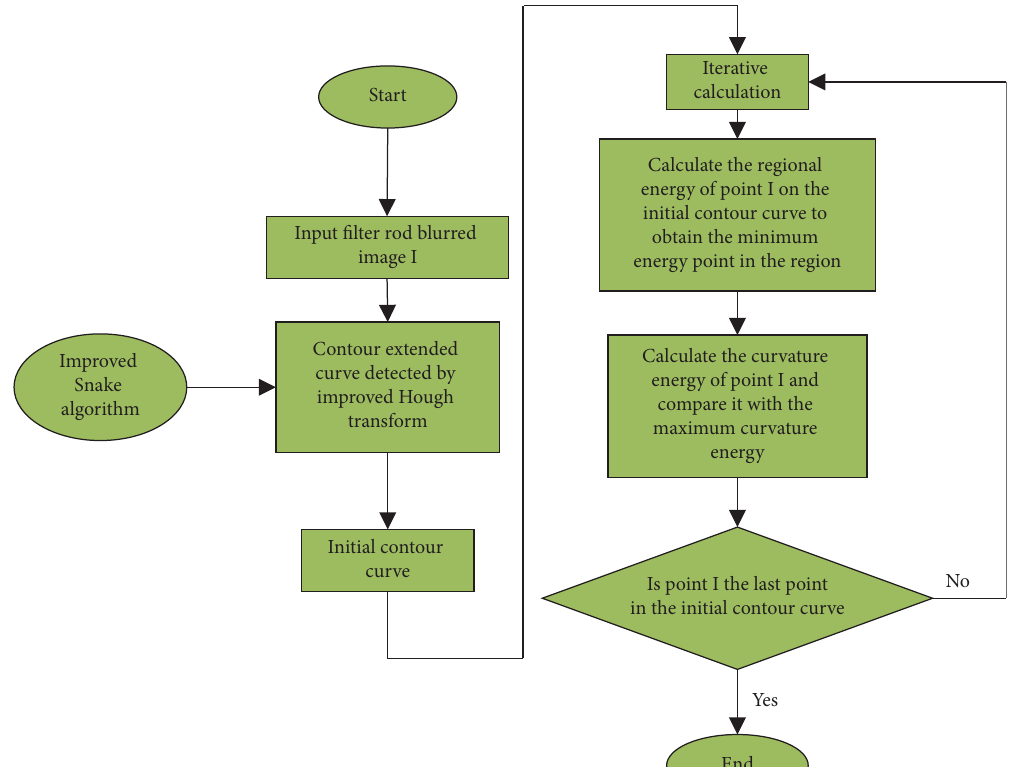
Figure 1: Implementation steps of the improved snake model